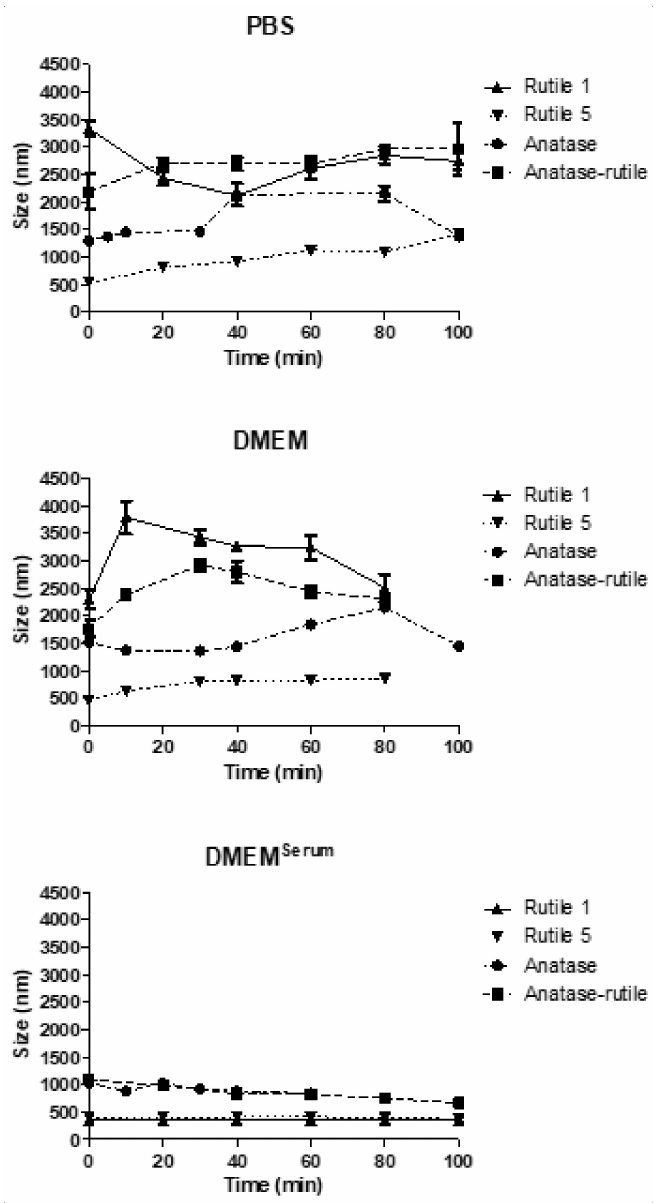
Figure 3. The time-dependent change in particle size of TiO 2 particles in media used for in vitro experiments. The starting concentration of the TiO 2 particles was 0.5 mg/mL dispersion